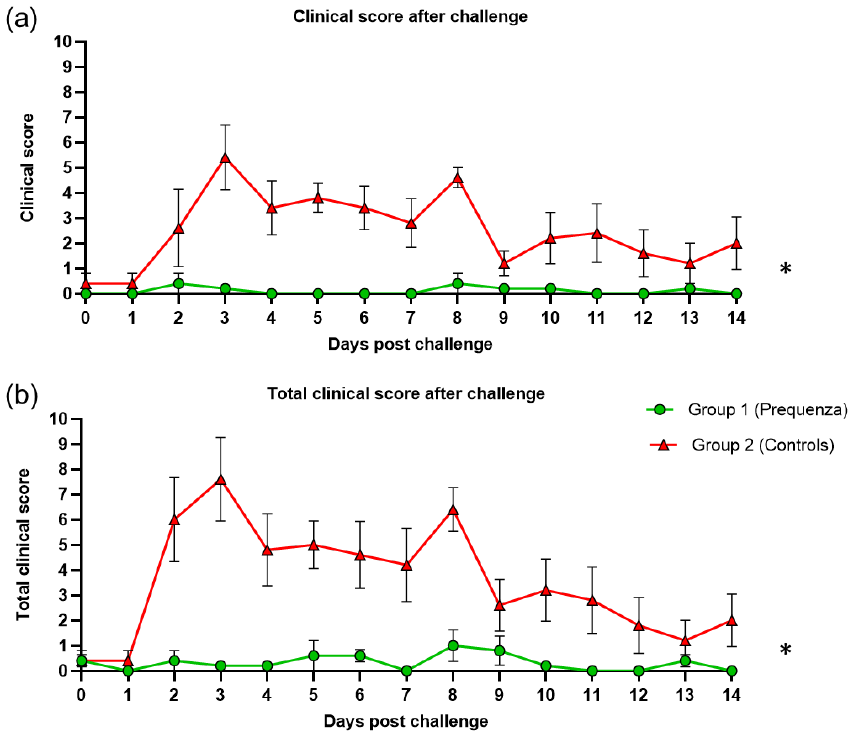
Figure 3. ( a ) Clinical score (clinical score excluding rectal temperature) and ( b ) total clinical score (clinical signs and rectal temperature) in groups 1 and 2 after challenge with H3N8 A/equine/Venlo/19 (FC1 sub-lineage). Green square = group 1, Equilis Prequenza vaccinated group; red triangle = group 2, unvaccinated control group. Error bars represent SEM. Inferential statistics: significant difference ( p < 0.05) between groups 1 and 2 (*) (mean effect between 1 and 14 dpc).